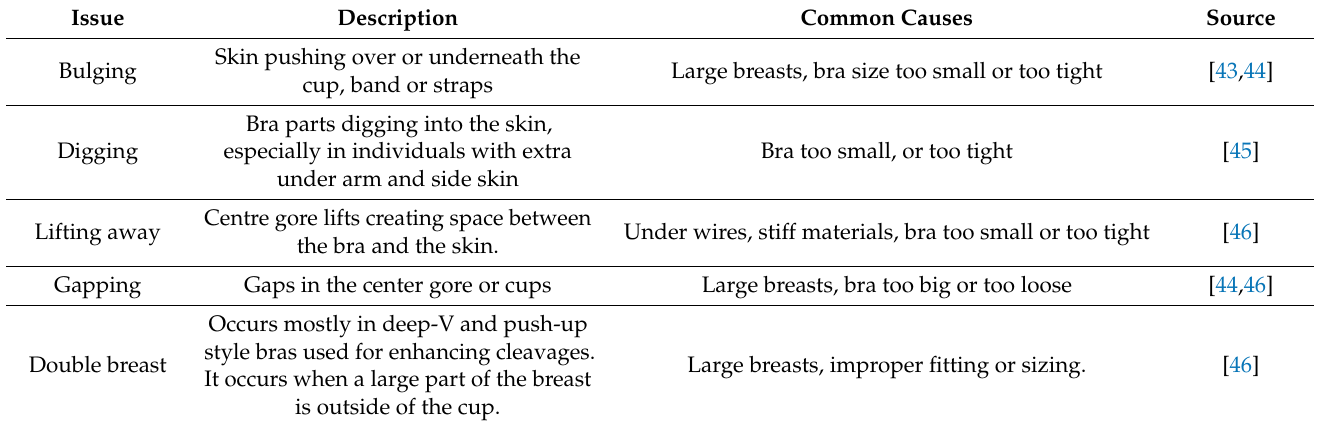
Table 1. Description of some bra issues, and their common